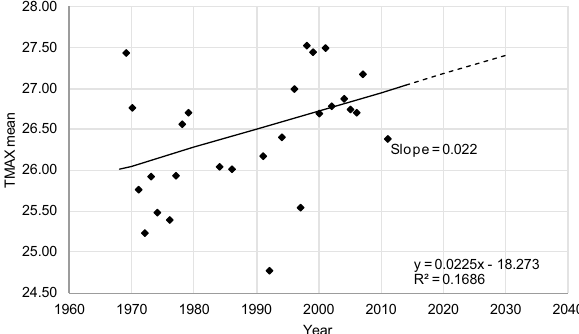
Fig. 11 Indices monthly mean value of daily maximum temperature Al Safawi forecasting till 2030